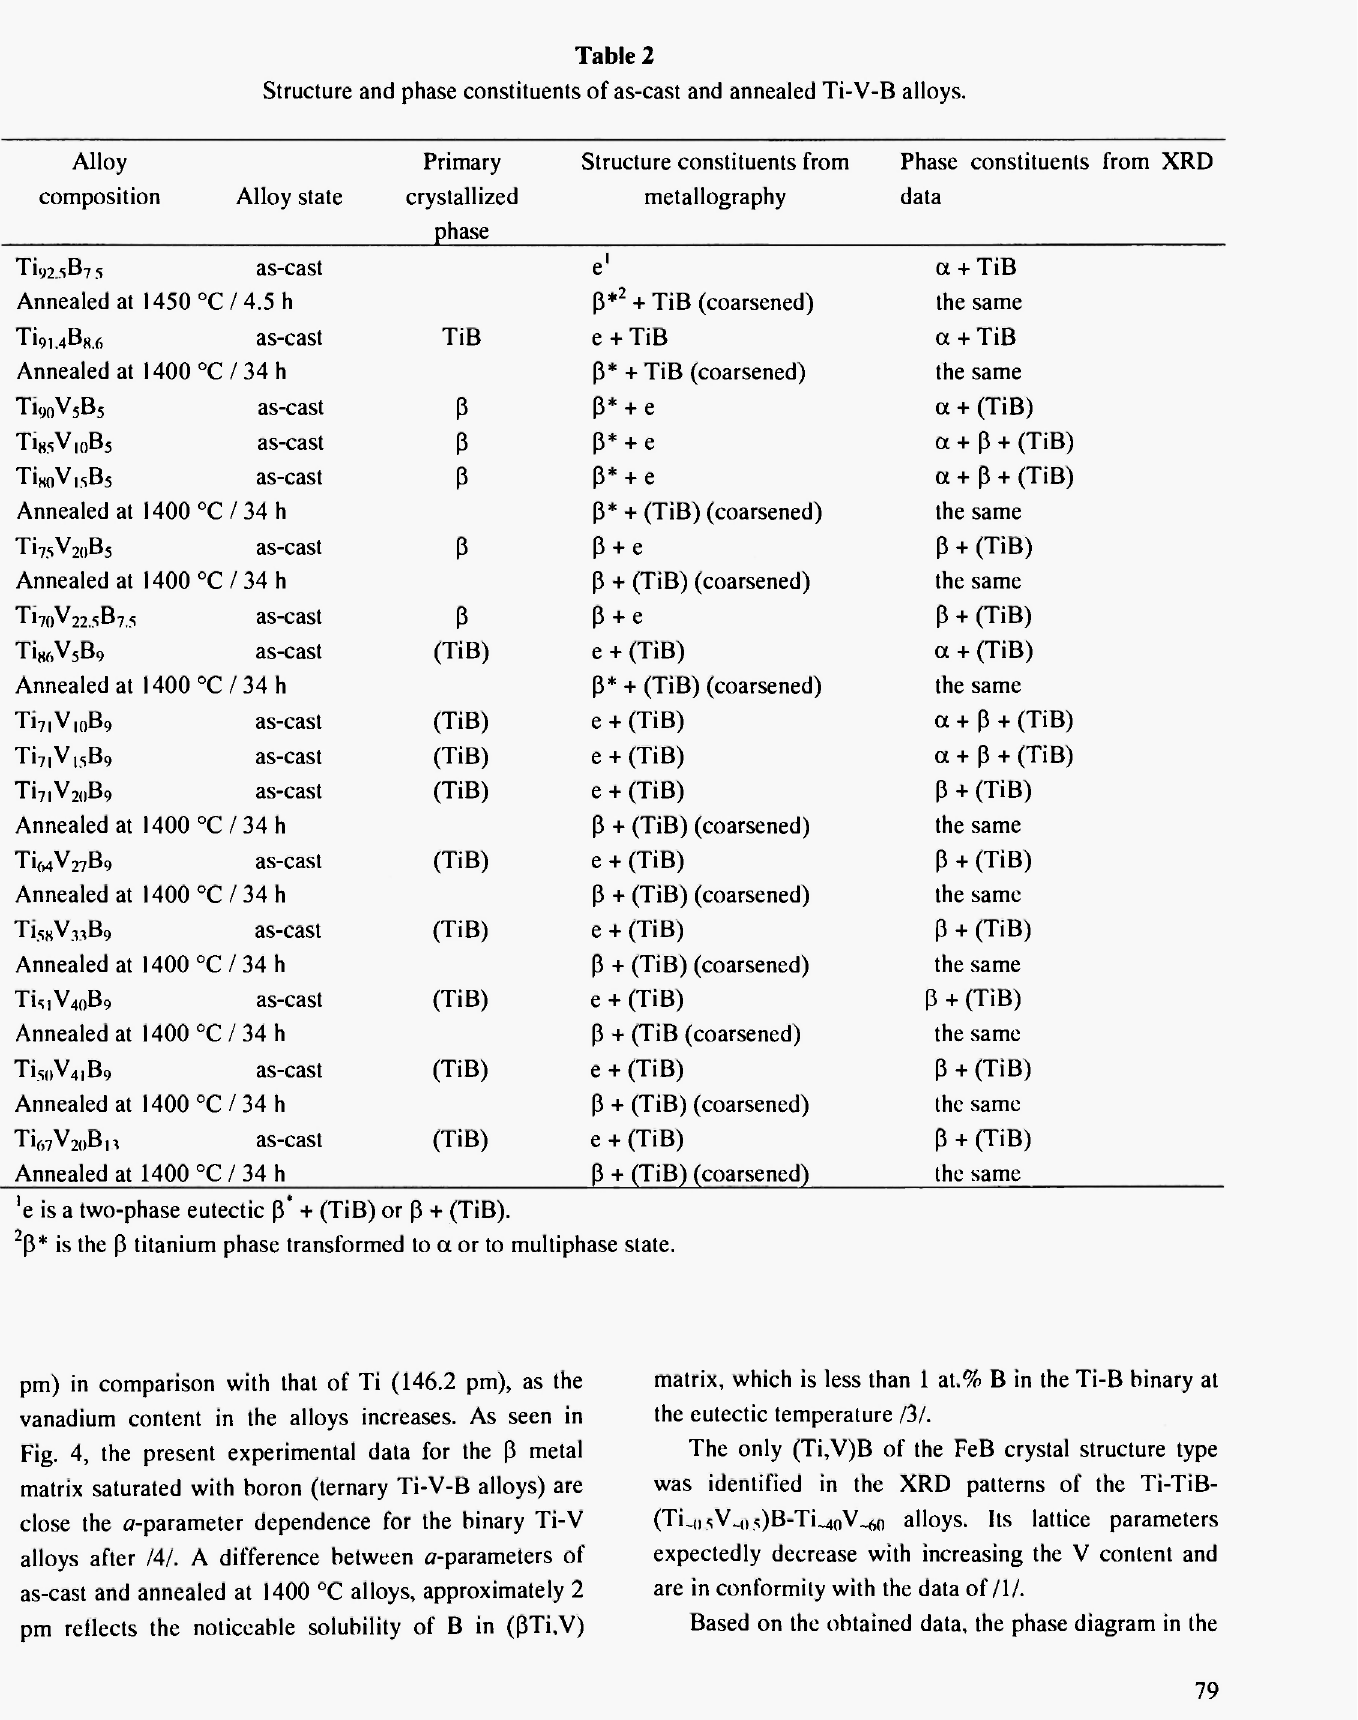
Fig. 4, the present experimental data for the β metal matrix saturated with boron (ternary Ti-V-B alloys) are close the α-parameter dependence for the binary Ti-V alloys after /4/. A difference between α-parameters of as-cast and annealed at 1400 °C alloys, approximately 2 pm retlects the noticeable solubility of Β in (ßTi,V)